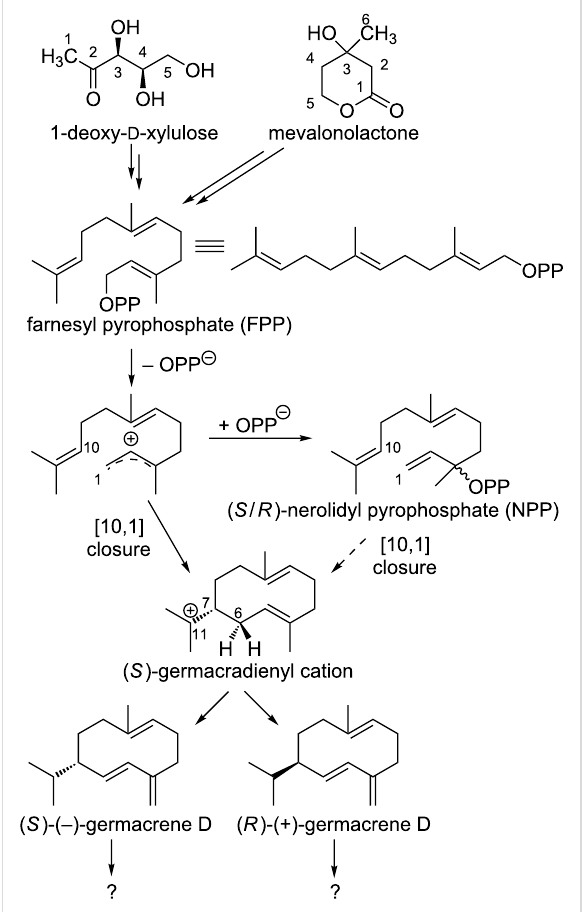
Scheme 1: First steps towards the formation of sesquiterpenes. The ( S )-germacradienyl cation can be formed from FPP or NPP. The subsequent formation of sesquiterpene hydrocarbons via ( S )- and ( R )- germacrene D has not yet been